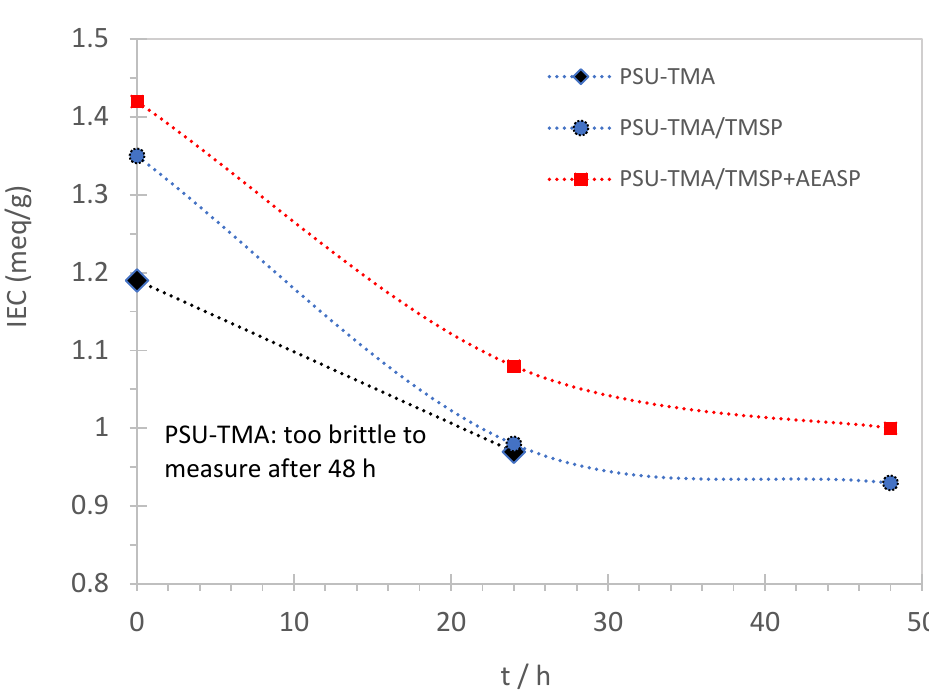
Figure 2. Ion exchange capacity of sol–gel membranes as function of the degradation time in KOH at 60 °C.